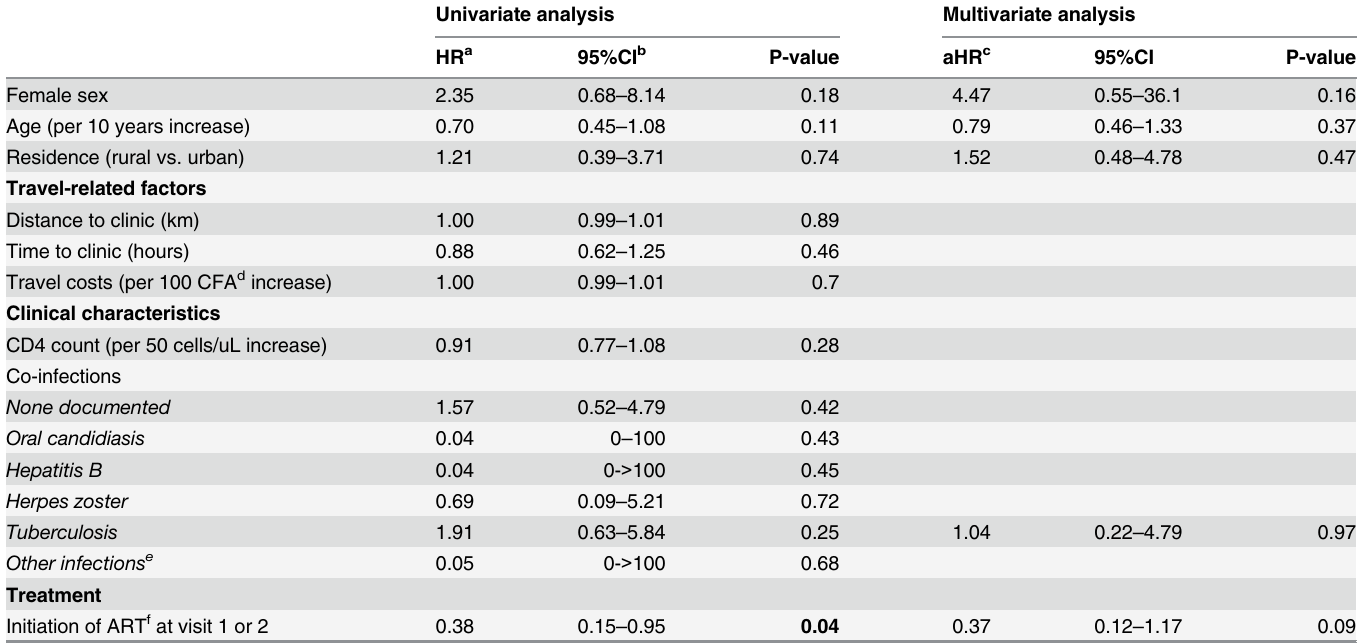
Table 3. Factors associated with mortality among adult non-pregnant HIV-patients, attending the primary HIV clinic in Lambaréné, Gabon, between January 2010 and January